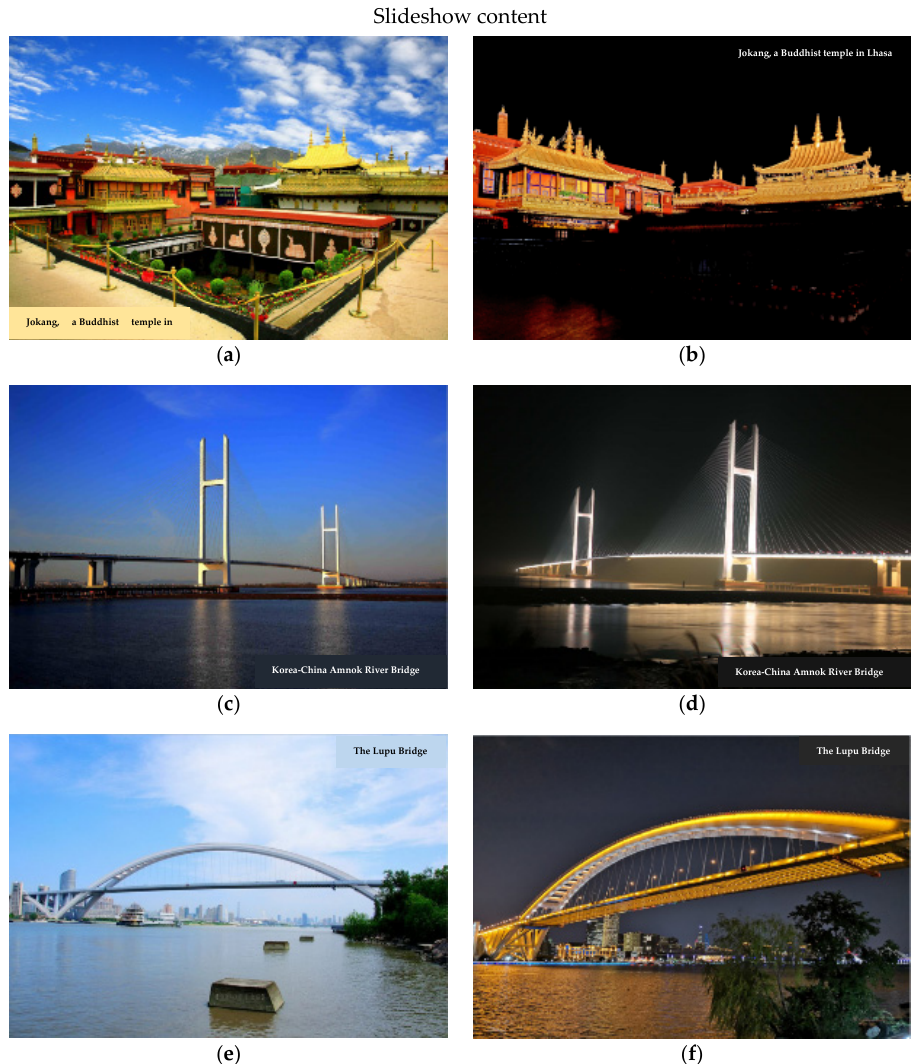
Figure 4. Examples of the slideshow contents. Reprinted with permission from refs. [27–32]. Accessed on 22 November 2021. ( a ) Temple landscape (day view), ( b ) temple landscape (night view), ( c ) cable-stayed bridge landscape (day view), ( d ) cable-stayed bridge landscape (night view), ( e ) arch bridge landscape (day view), ( f ) arch bridge landscape (night view).